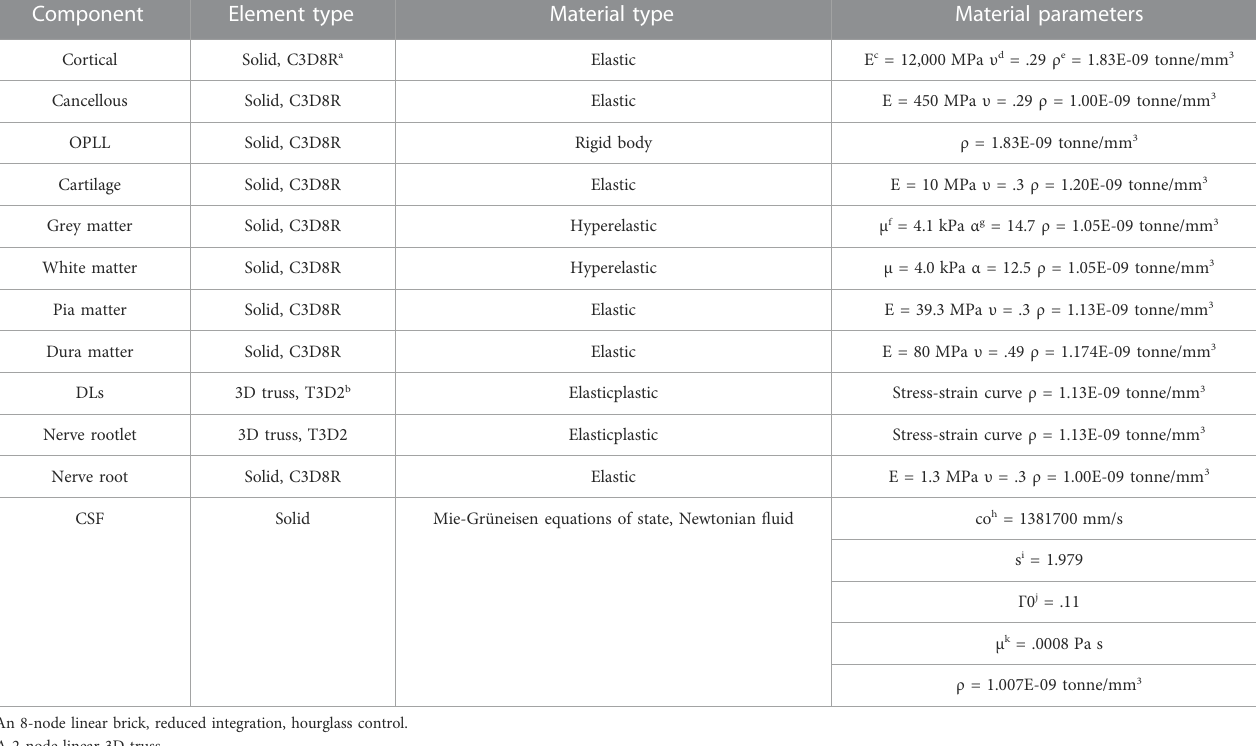
TABLE 1 Material properties and element types used in the current